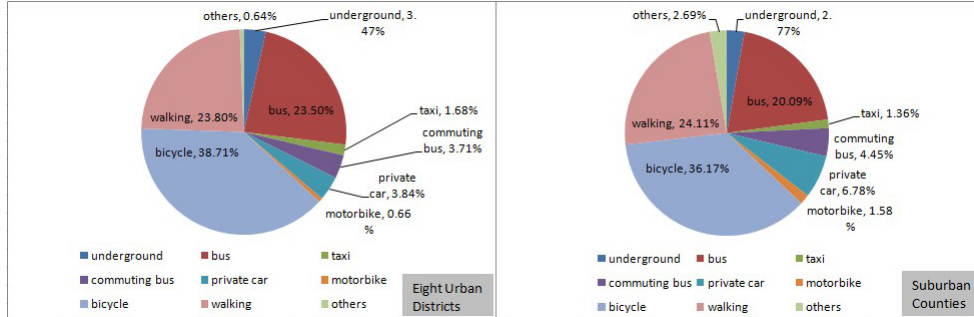
Fig. 7. Proportions of travel modes for families with a car ownership in Beijing (2005) Source: Annual Report of Beijing Transport Development